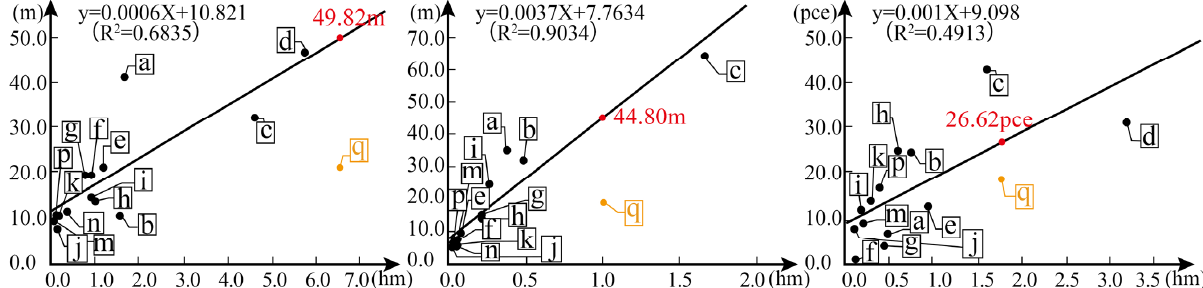
Figure 6. Relationship between Average Connection Length of HP (left) and MP (middle), number of CP (right) and service area of paths (Red: Theoretical value of Daguan Garden; Yellow: Actual value of Daguan Garden.) (See Figure 1 for abbreviations of garden names).